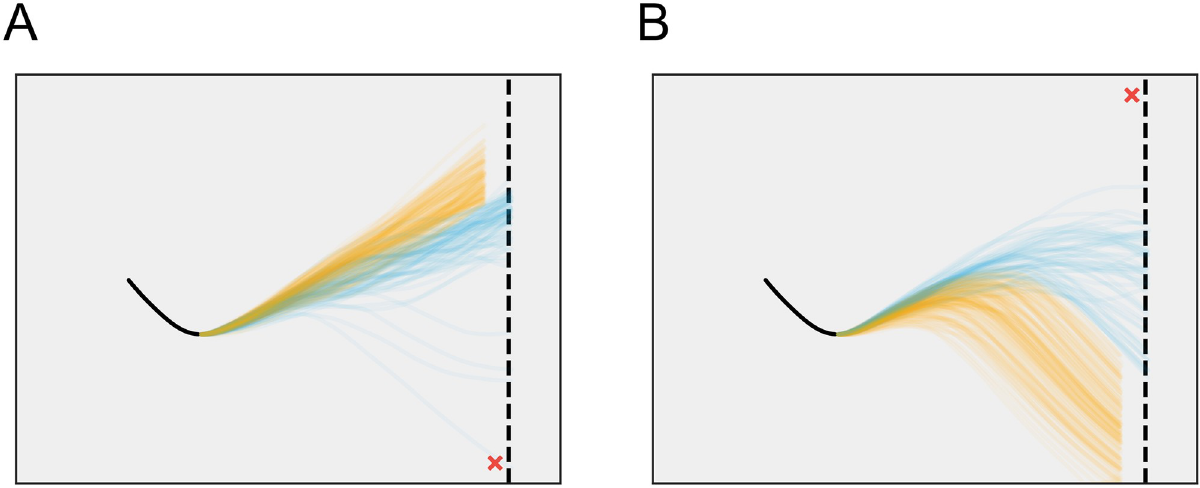
Fig 7. Effects of goal states. A: Completed puck trajectories (n = 200) for the trial in Fig 6C with the goal state at 7 screen (only trials that last less than 25 set at the top of the screen (only trials that last less than 25